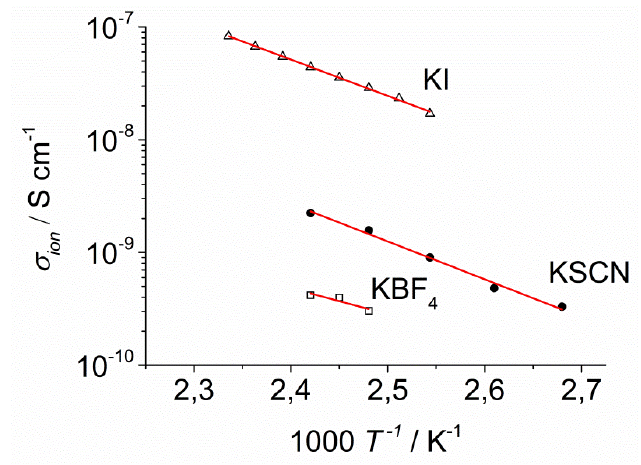
Figure 13. Arrhenius diagram of the ionic conductivity of KI-2c (∆), KSCN-2c (●), and KBF 4 -2c (□). 414 The conductivity for KI-2c (4·10 −8 S cm -1 at 140 °C = 2.42 × 10 –3 /K in Figure 13) was 20 times higher 415 than for KSCN-2c and 100 times higher than for KBF 4 -2c . This result suggests that the anions 416